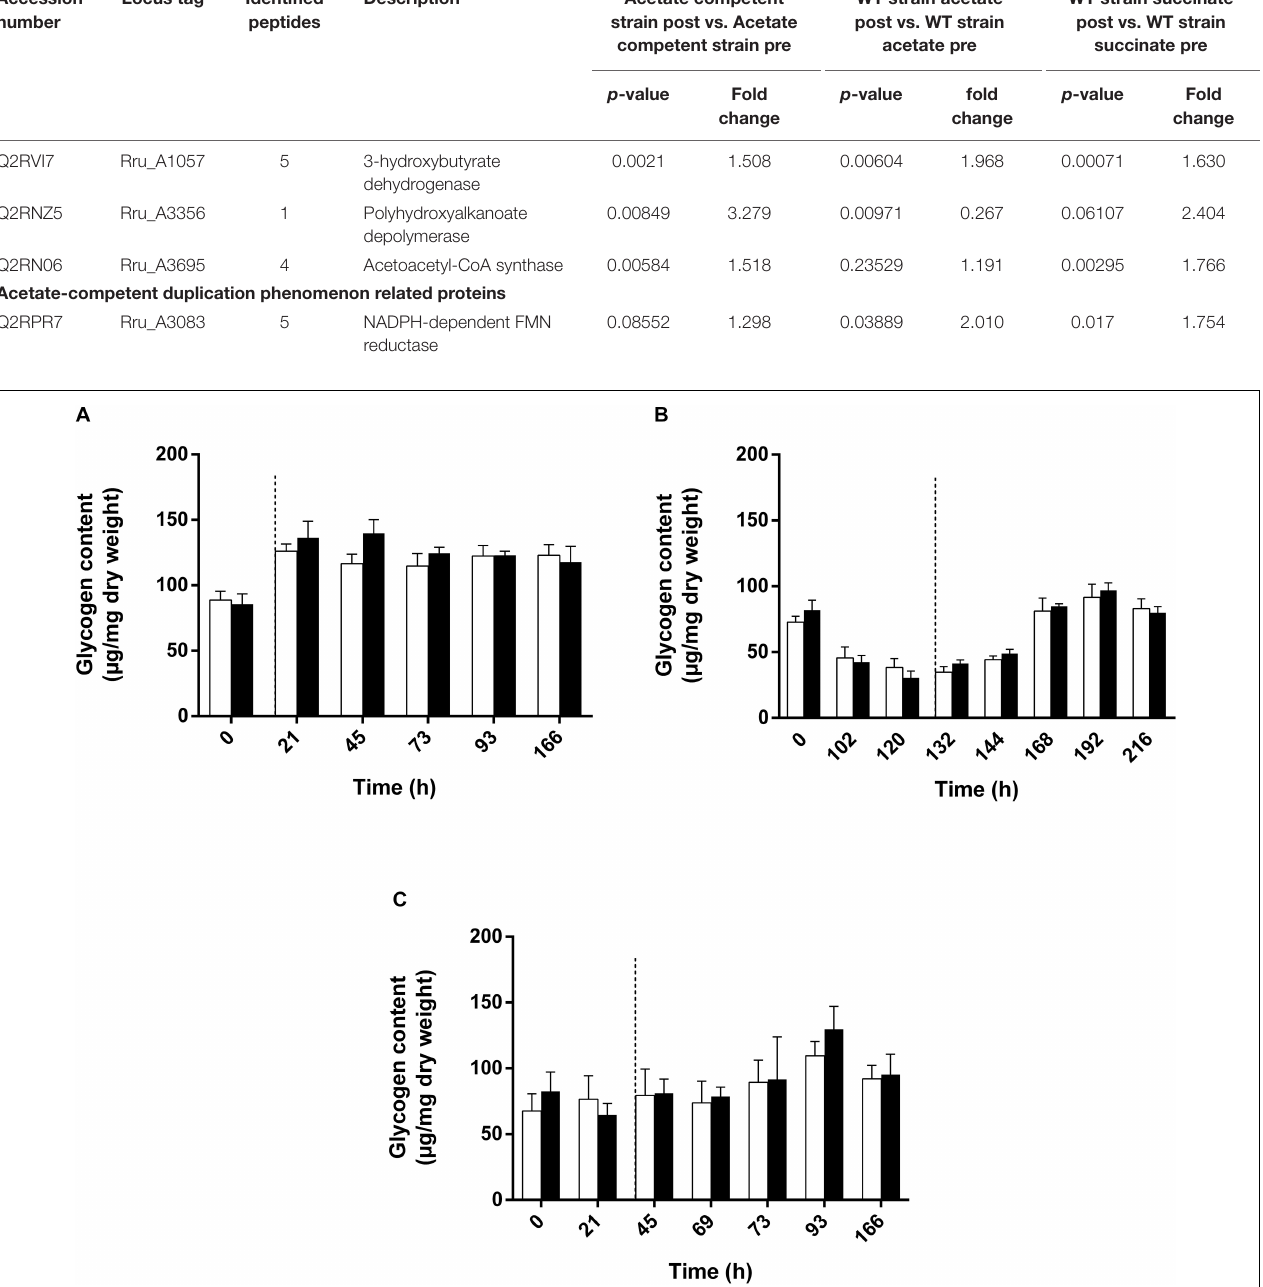
FIGURE 6 | Polysaccharide quantification of WT Rs. rubrum cultivated with succinate (A) , acetate and 3 mM HCO 3 − (B) or the acetate-competent strain cultivated with acetate (C) . Uncolored bars represent the condition without any light stress; dark colored bars represent the condition subjected to the light stress. Dotted black lines represent the increase in light intensity from 50 to 150 µ mol of photons/m 2